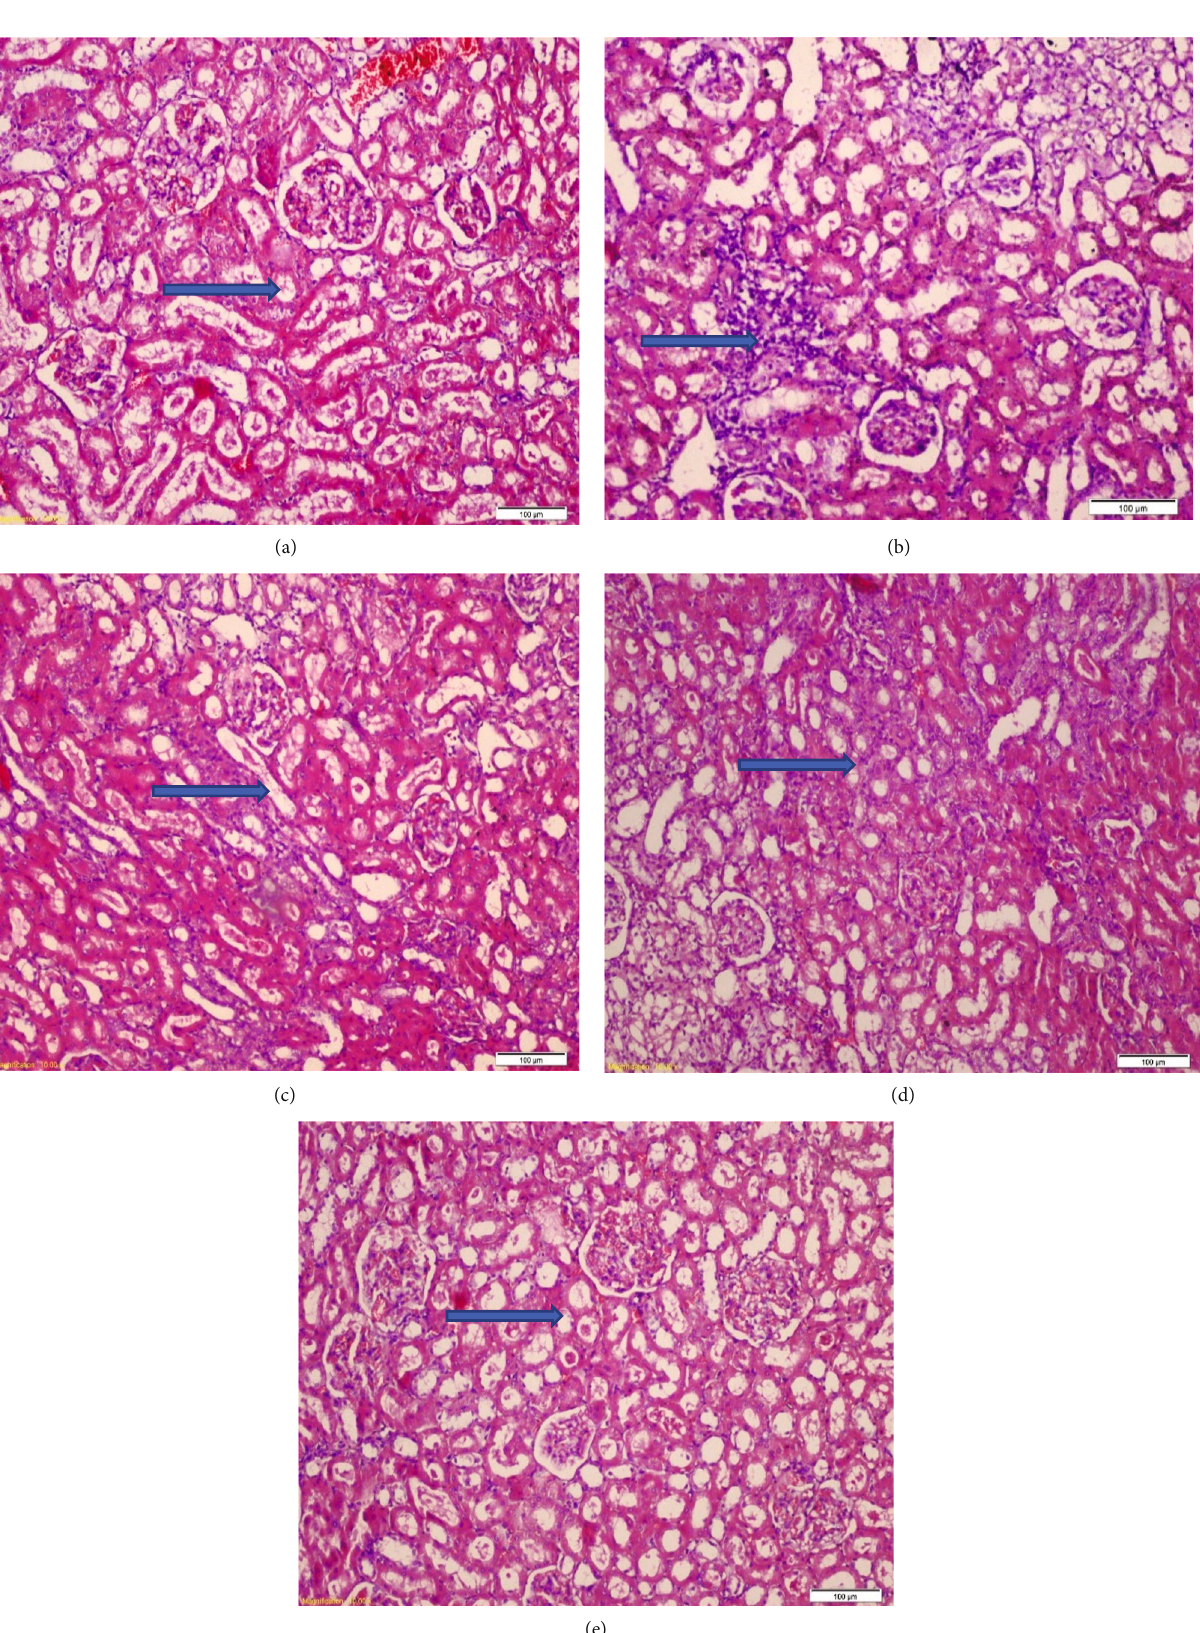
Figure 7: (a) The renal tissues of G1 with normal renal architecture and glomeruli (arrow). (b) The renal tissues of G2 with drastically injured renal tissues (arrow). (c) The renal tissues of G3 with mildly injured tissues (arrow). (d) The renal tissues of G4 with nearly normal renal tissues (arrow). (e) The renal tissues of G5 with nearly normal renal tissues (H&E, X = 200